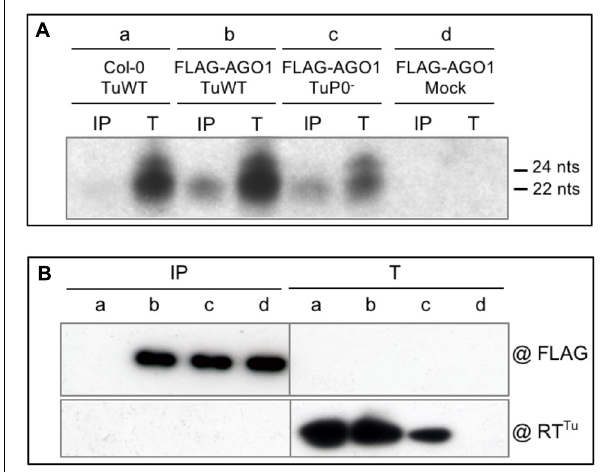
FIGURE 2 | Analysis of vsiRNA generated during TuYV infection. (A) Characterization of TuYV-vsiRNA loaded on FLAG-AGO1 protein. Wild-type TuYV (TuWT) ( a and b ) or P0-deficient TuYV (TuP0 - ) (c) were agroinoculated to A. thaliana Col-0 plants (a) or FLAG-AGO1/ago1-36 (FLAG-AGO1) plants ( b , c , and d ). Plant material was harvested 26 dpi from upper non-inoculated leaves. Total RNA extracted from infected plants (T) or vsiRNA bound to FLAG-AGO1 extracted after immunoprecipitation with FLAG antibodies (IP) were analyzed by northern blot. Hybridization was performed using a TuYV probe corresponding to the 3 (cid:48) end of genomic RNA. The size of the small RNA is indicated on the right. (B) Protein input (T) and immunoprecipitated FLAG-AGO1 proteins using FLAG antibodies (IP) were analyzed by western blot using anti-FLAG antibodies (@FLAG, upper part) or antibodies specific to the TuYV minor capsid protein RT (@RT Tu ) (lower